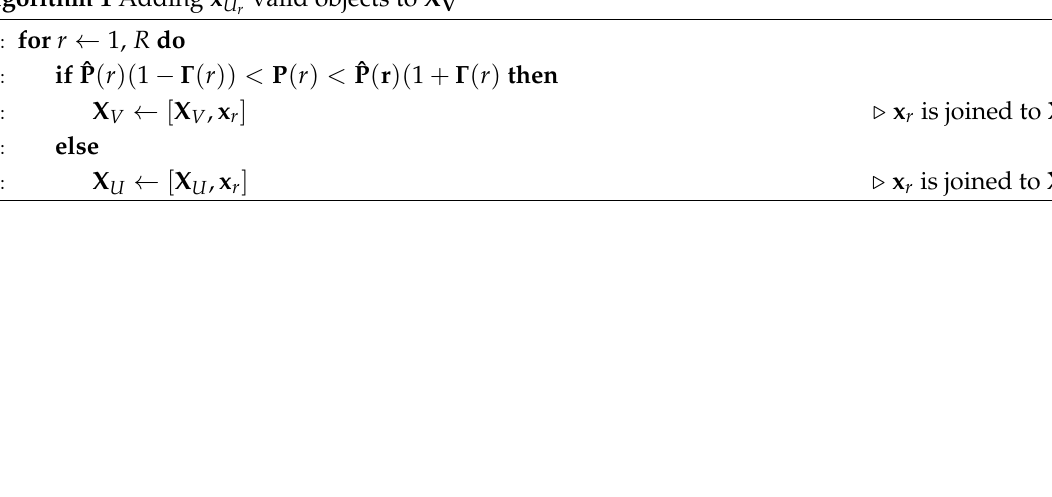
Figure 2. Raw Data contained in X valid objects to X r